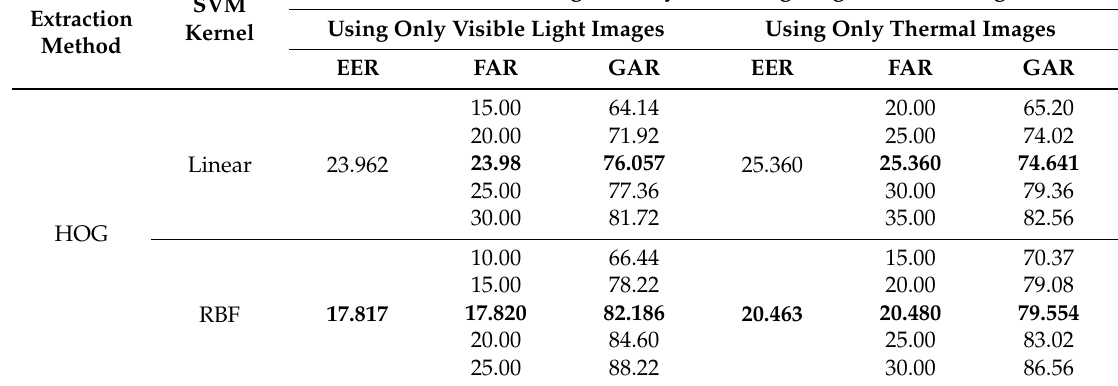
Table 4. Recognition accuracies of previous method [16] using single visible light image or single thermal image for gender recognition (unit: